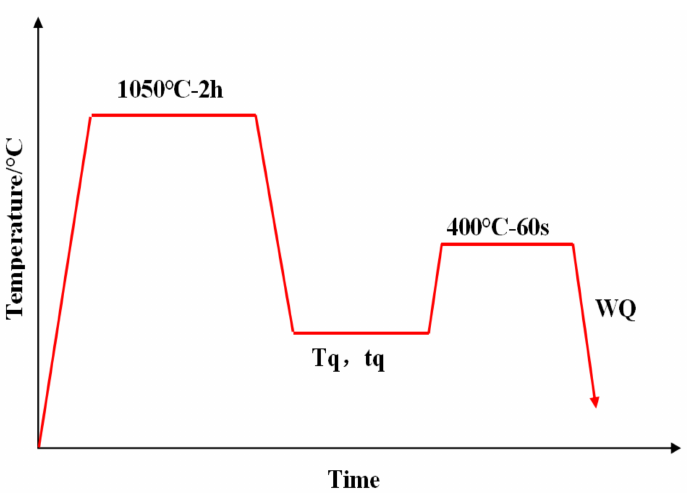
Figure 1. The scheme of the quenching and partitioning (Q&P) heat treatment process of the high boron steel.